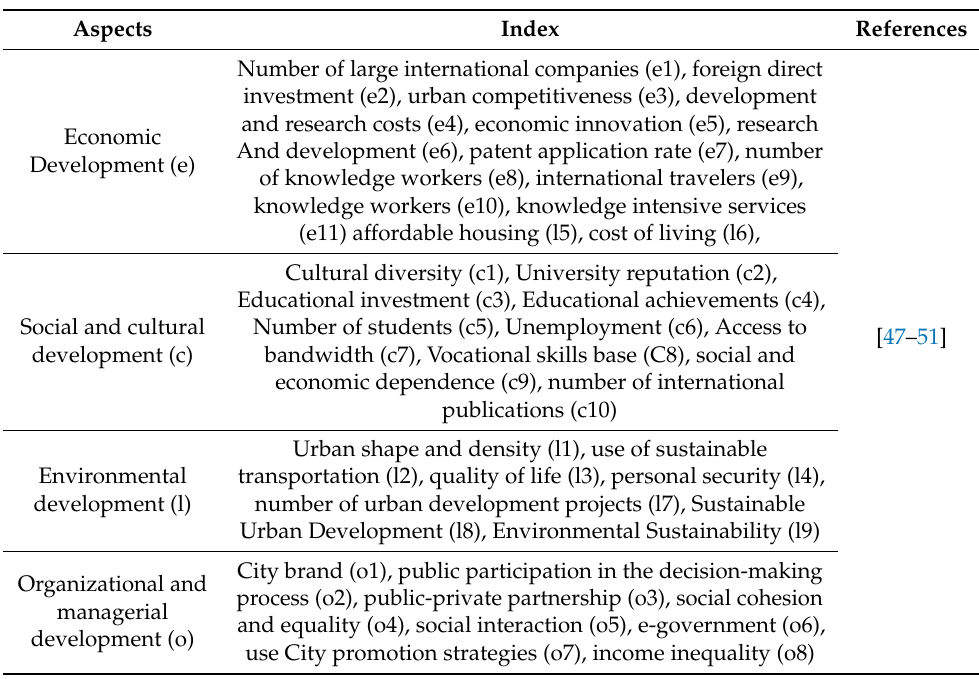
Table 2. Knowledge-based city